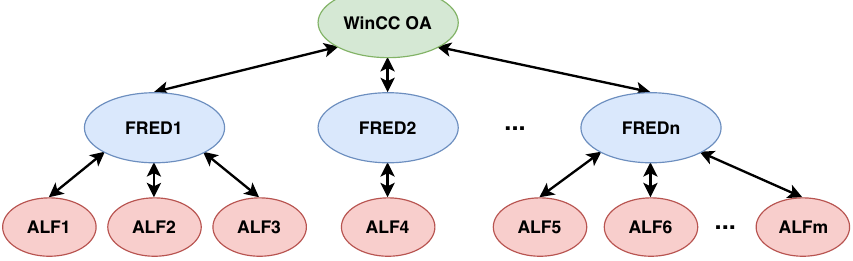
Figure 4. Distributed structure of the ALFRED